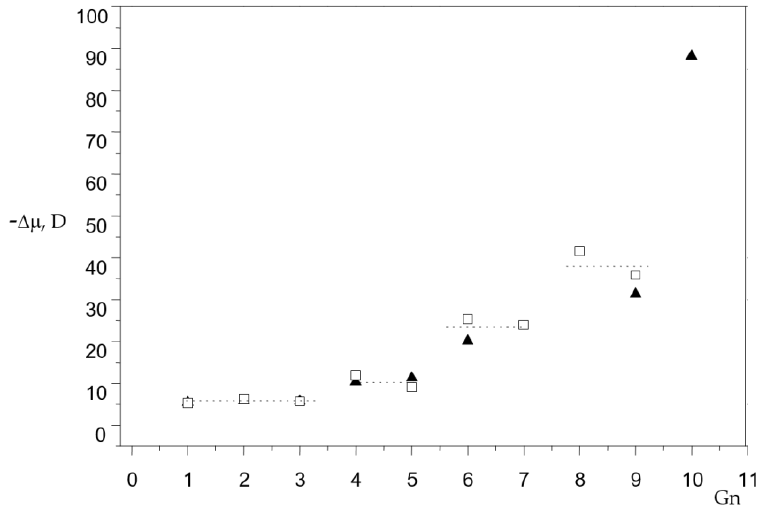
Figure 3. Dipole moments (D) are increased in steps based on the number of generations ( (cid:78) (cid:3) - dendrimers with terminal chlorine atoms, - dendrimers with oxybenzaldehyde terminal groups). Table 1. Analysis of dipole moments of molecules of phosphorus-containing dendrimers.